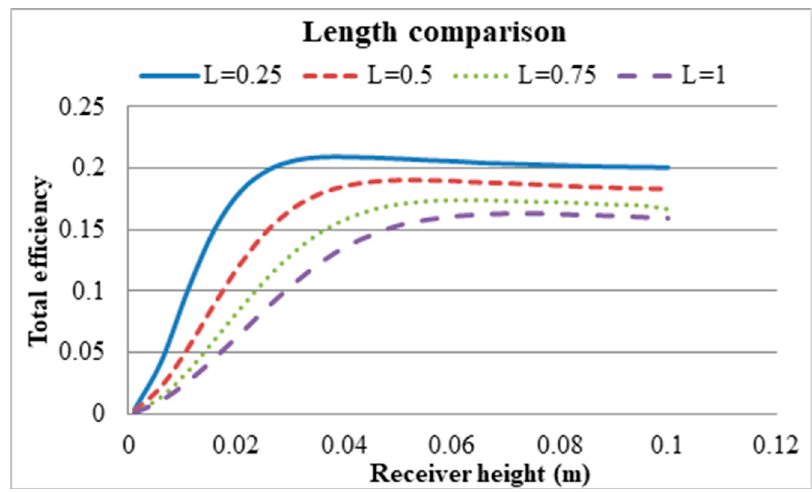
Figure 12. Change of total efficiency (receiver efficiency × Carnot efficiency) with receiver lengths.